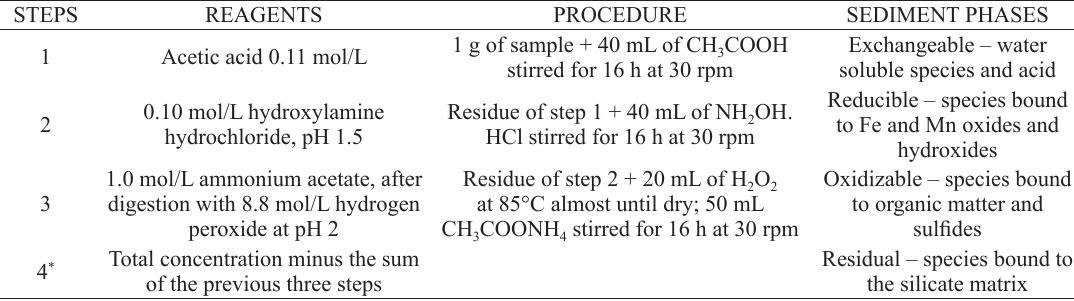
The BCR sequential extraction